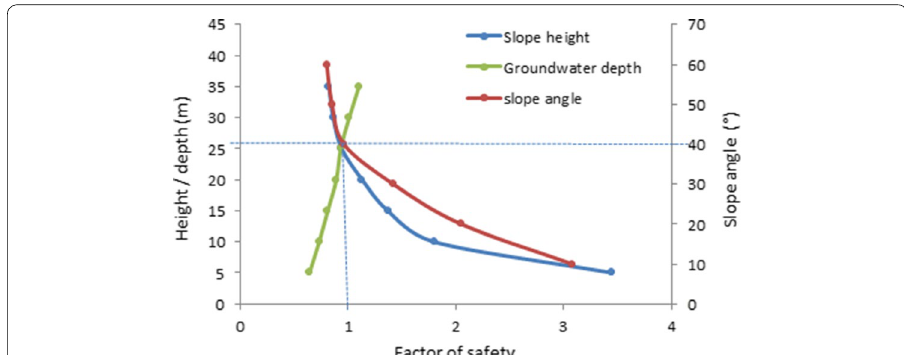
Fig. 15 Combined effect of slope geometry and groundwater level